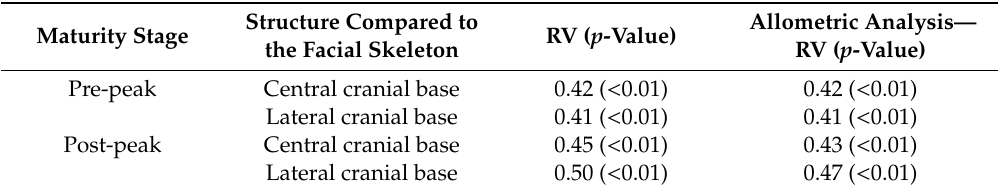
Table 3. Values of the overall correlation (RV) for the PLS analyses, with a single overlap of landmarks and the results of the permutation test ( p -value).